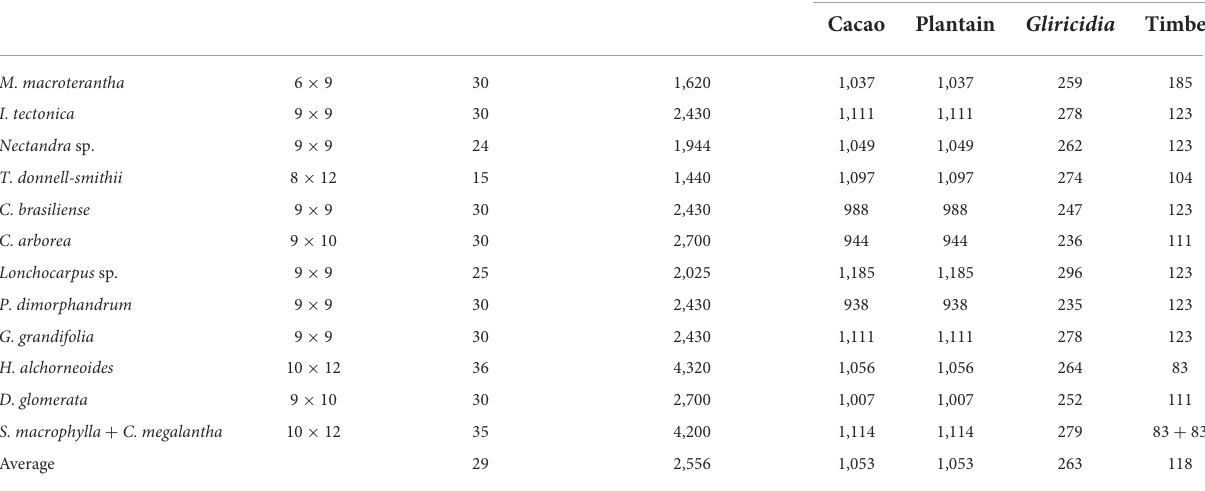
TABLE 1 Planting arrangements and densities of measured timber-based agroforestry systems in the “CEDEC-JAS” experimental site at La Masica, Atlántida, Honduras. Species Distance (m) Number of trees Useful study area (m 2 ) Extrapolation to hectare (# stems/ha)